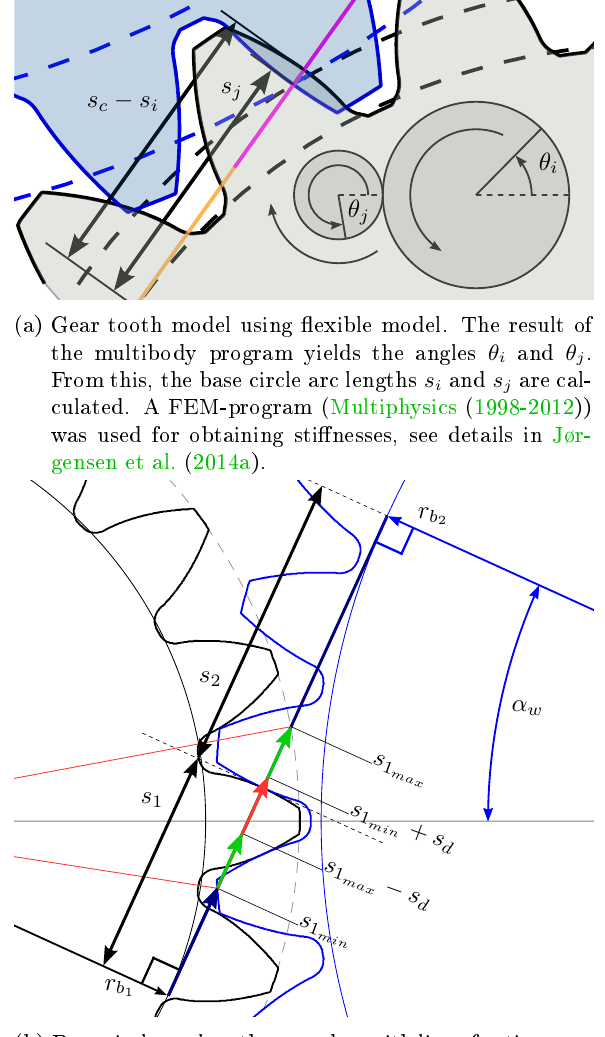
arrows indicate 2 teeth in contact (high sti(cid:27)ness) and the red arrow indicates 1 tooth in contact with the other gear. Figure 7: Tooth penetration and estimation of equiva- lent sti(cid:27)ness from (cid:29)exible multibody model. The sum of distances s 1 + s 2 = s c is a con- stant, see additional details in Pedersen and Jłrgensen